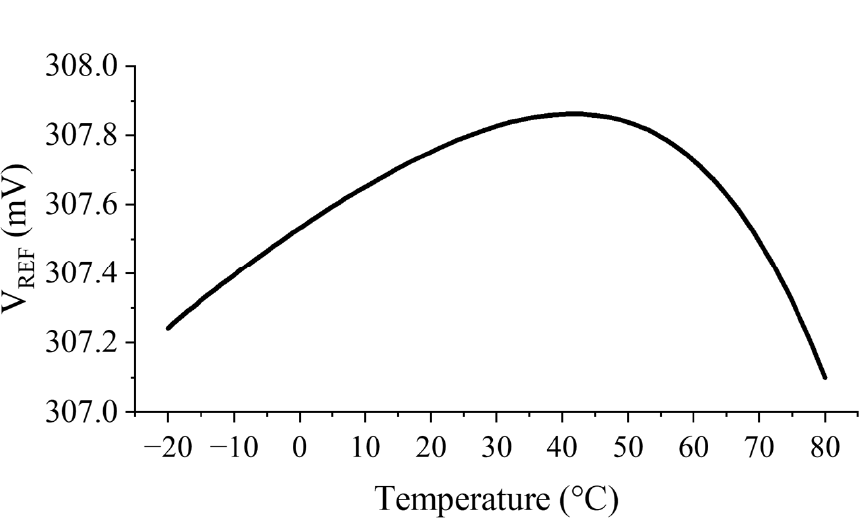
Figure 12. Simulated temperature variation of V REF .